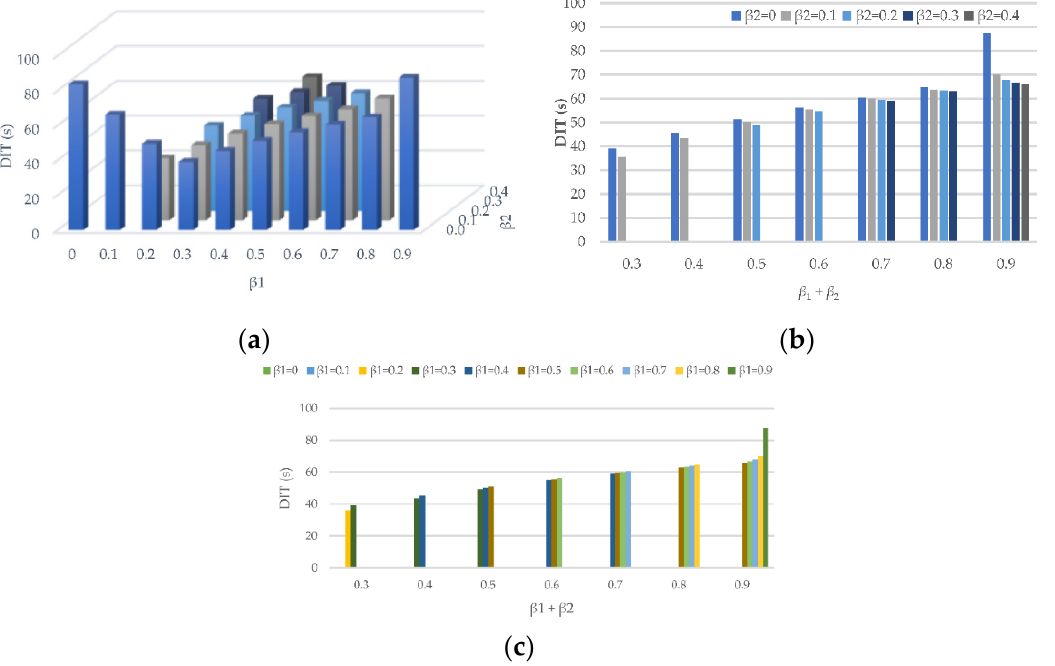
Figure 9. Mean value of DIT for 99 vehicles under the different combinations of β 1 and β 2 (s). ( a ) The relationship between DIT and β 1 and β 2 ; ( b ) The relationship between DIT and β 2 when β 1 + β 2 is fixed; ( c ) The relationship between DIT and β 1 when β 1 + β 2 is fixed.